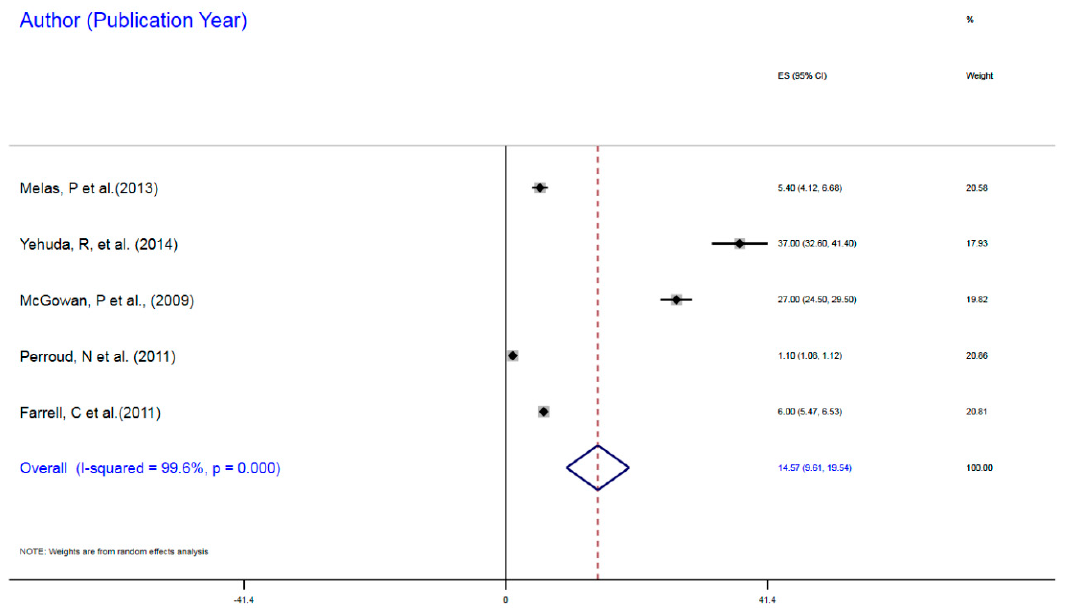
Figure 2. DNA Methylation of NR3C1 (glucocorticoid receptor gene) in Social Adversity as Early Life Stress and Major Depressive Disorder Correlation.